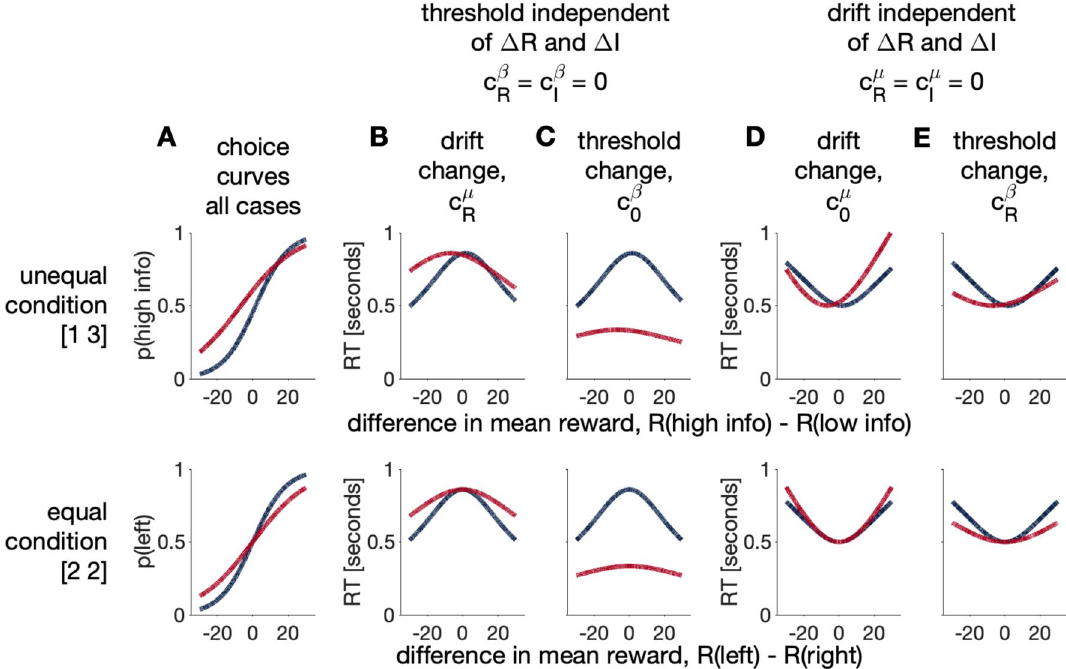
Figure 5. Qualitative predictions for the logistic versions of the drift-diffusion model using manually chosen parameters. Blue and red lines correspond to horizon 1 and 6, respectively. ( A ) With appropriately chosen parameter values, there are four ways in which the diffusion model reduces to the logistic choice model. All four models have identical choice behavior. However, they differ in the patterns of response times that they produce ( B , C , D , E ). ( B , C ) In the case where threshold is independent of reward and information, c there is a maximum response time. A change in drift with horizon leads to slower response times in horizon 6 than horizon 1 ( B ), while a change in threshold with horizon leads to faster response times in horizon 6 than horizon 1 ( C ). ( D , E ) When drift rate is independent of reward and information, c Supplementary Material for parameter